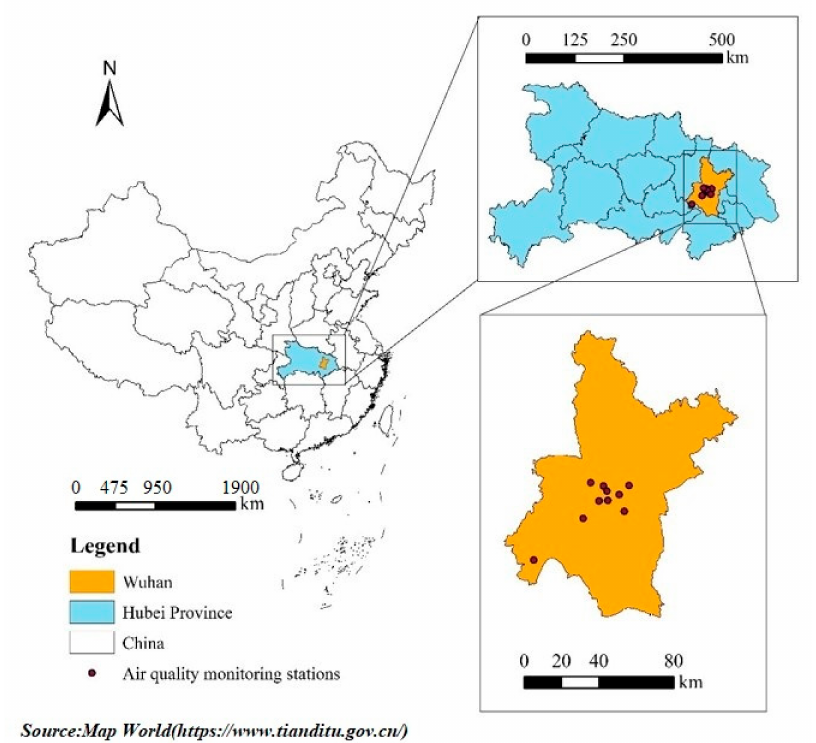
Figure 1. Locations of monitoring